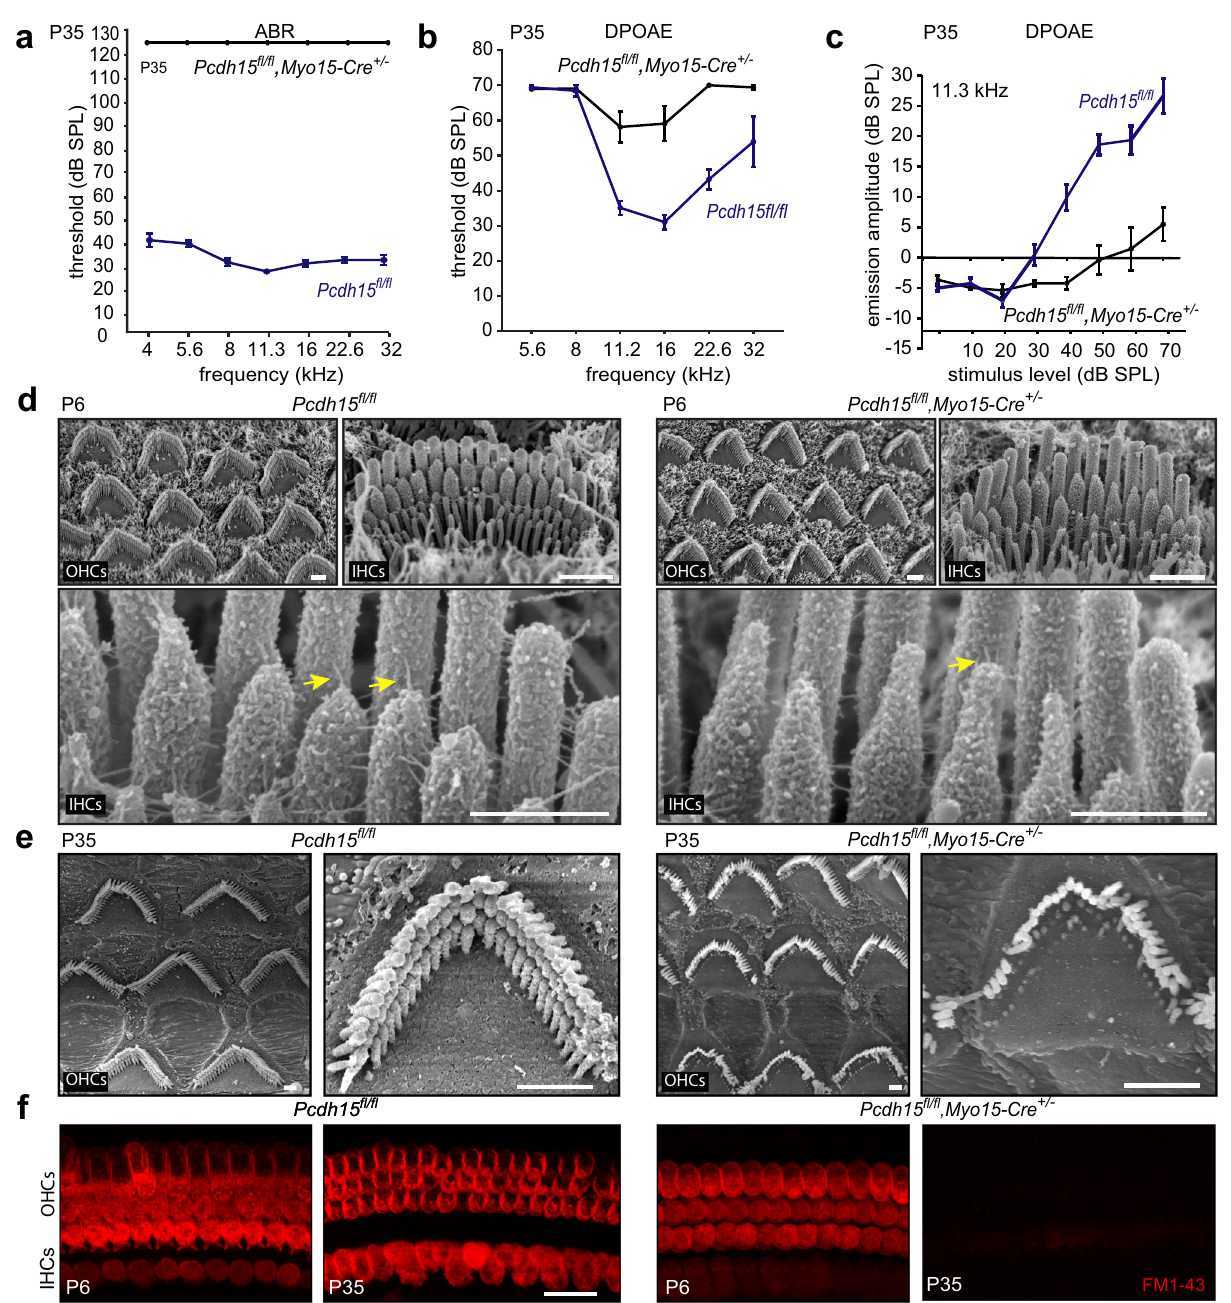
Fig. 3 | Myo15-Cre conditional knockout mice show delayed functional and morphological cochlear pathology. a P35, Pcdh15 fl / fl ,Myo15-Cre +/ − knockout mice ( n =10) show lack of auditory brainstem response (ABR) thresholds at all fre- quencies and sound levels tested, compared to Pcdh15 fl / fl hearing control mice ( n =9). b At P35, knockout mice ( n =6) have residual distortion-product otoa- coustic emission (DPOAE) responses to high sound level stimuli in the mid-range frequencies, compared to Pcdh15 fl / fl control mice ( n =9). c Despite residual responses at high sound levels, DPOAE emission amplitude at 11.3kHz in P35 Pcdh15 fl / fl ,Myo15-Cre +/ − mice ( n =8) was signi fi cantly reduced compared to Pcdh15 fl / fl control mice ( n =9). d Scanning electron micrographs of P6stereocilia in Pcdh15 fl / fl hearing control mice (left) and Myo15-Cre conditional knockout mice (right) demonstrate healthy bundle morphology in neonatal knockout mice. High mag- ni fi cation images (lower panel) show extensive links between adjacent stereocilia